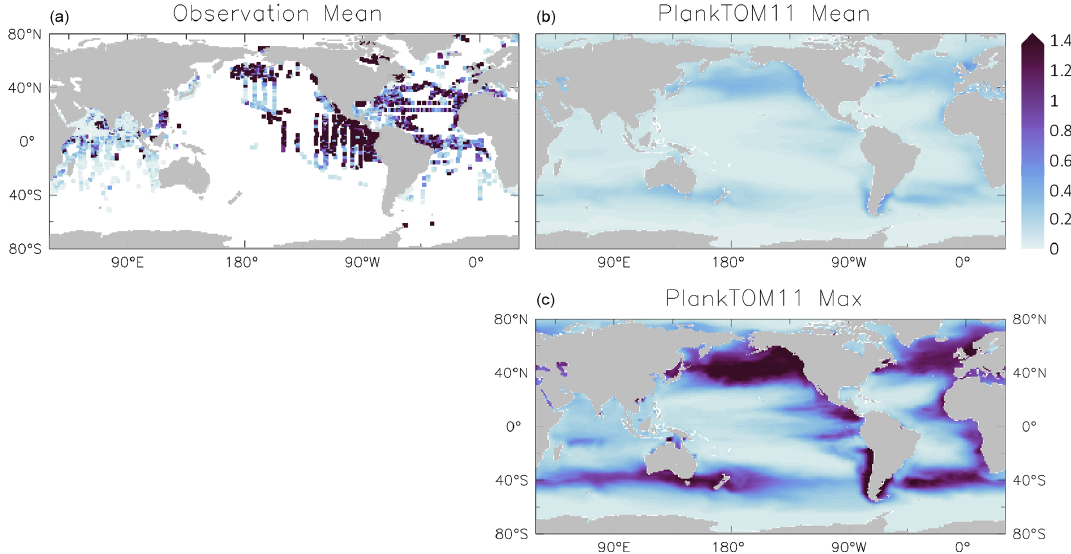
Figure 6. Jellyfish carbon biomass (µmolCL − 1 ) in PlankTOM11 and in observations from the Jellyfish Database Initiative (Luo et al., 2020). PlankTOM11 results (b, c) are the mean and maximum biomass from monthly climatologies. Observations (a) are the mean biomass; areas with no observations are in white. Observations are on a 1 ◦ × 1 ◦ grid and are plotted using a three-cell averaging filler for visual clarity. All data are for 0–200m. The gridded observation data are only available as a mean over time and depth (Luo et al., 2020). Due to the patchy nature of the observations in depth and time, the mean may be skewed high or low, while the model is sampled across the full time and